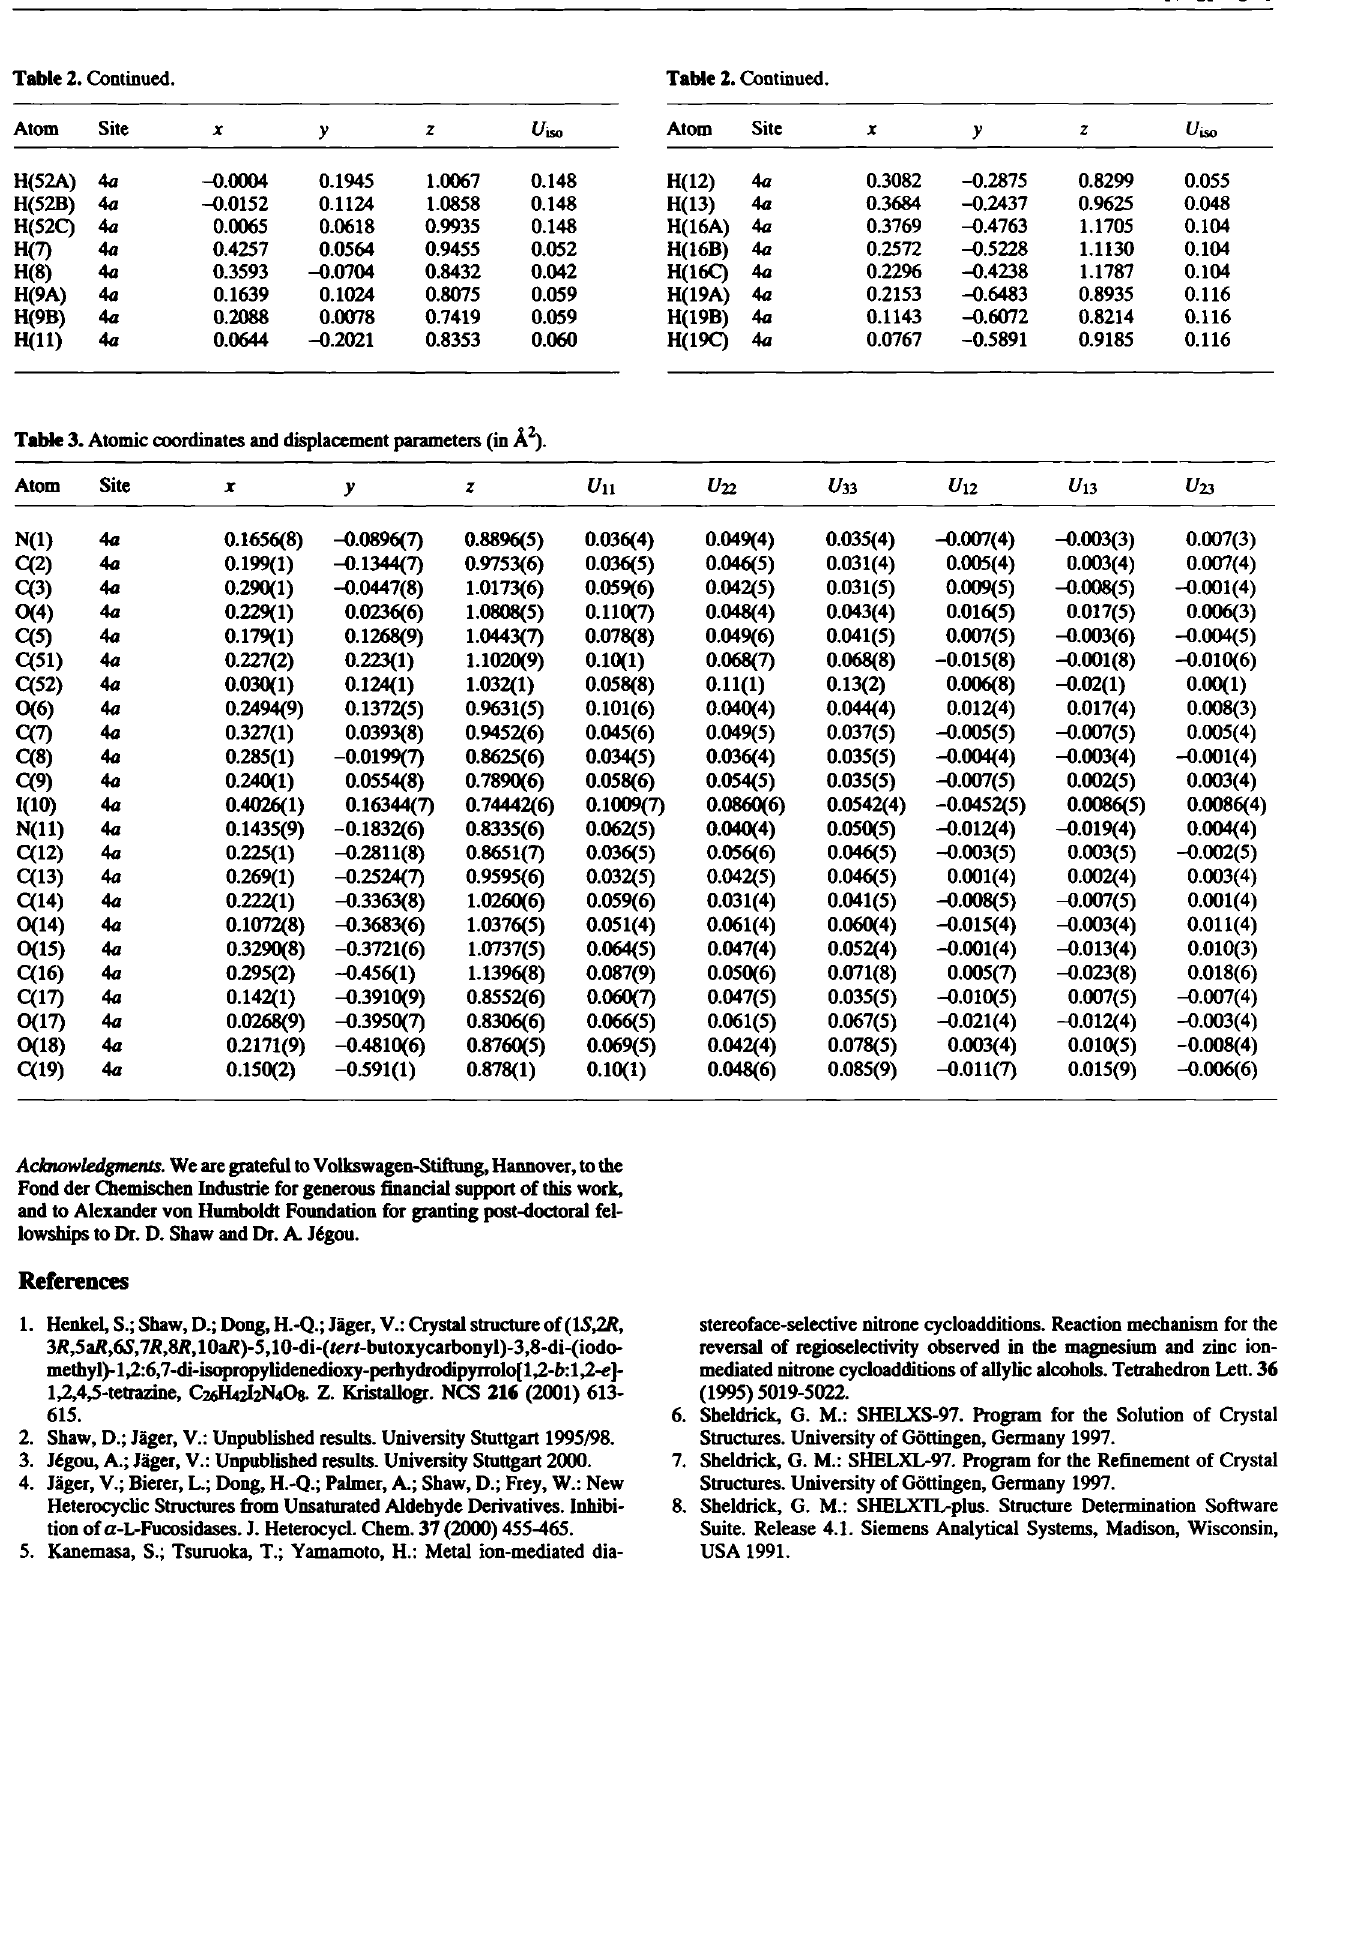
Table 3. Atomic coordinates and displacement parameters (in Ä 2